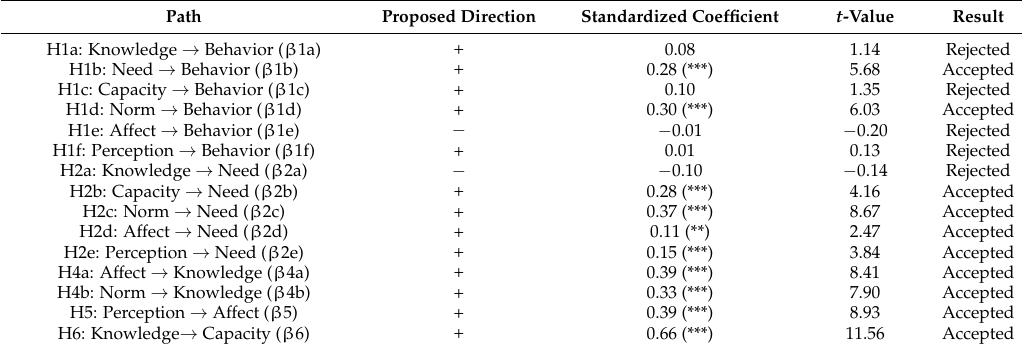
Table 4. Tests of the hypotheses.